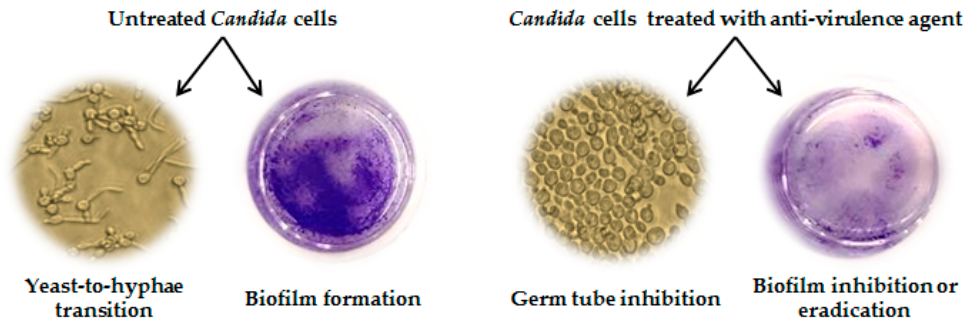
Figure 3. C. albicans cultures grown under conditions inducing yeast-to-hyphae transition and in presence of a representative agent inhibiting the expression of virulence factors. Untreated cells undergo transition to filamentous forms and produce a strong biofilm, stained with crystal violet. Treated cells are blastospores and budding cells but not hyphae, and the biofilm is faintly stained.